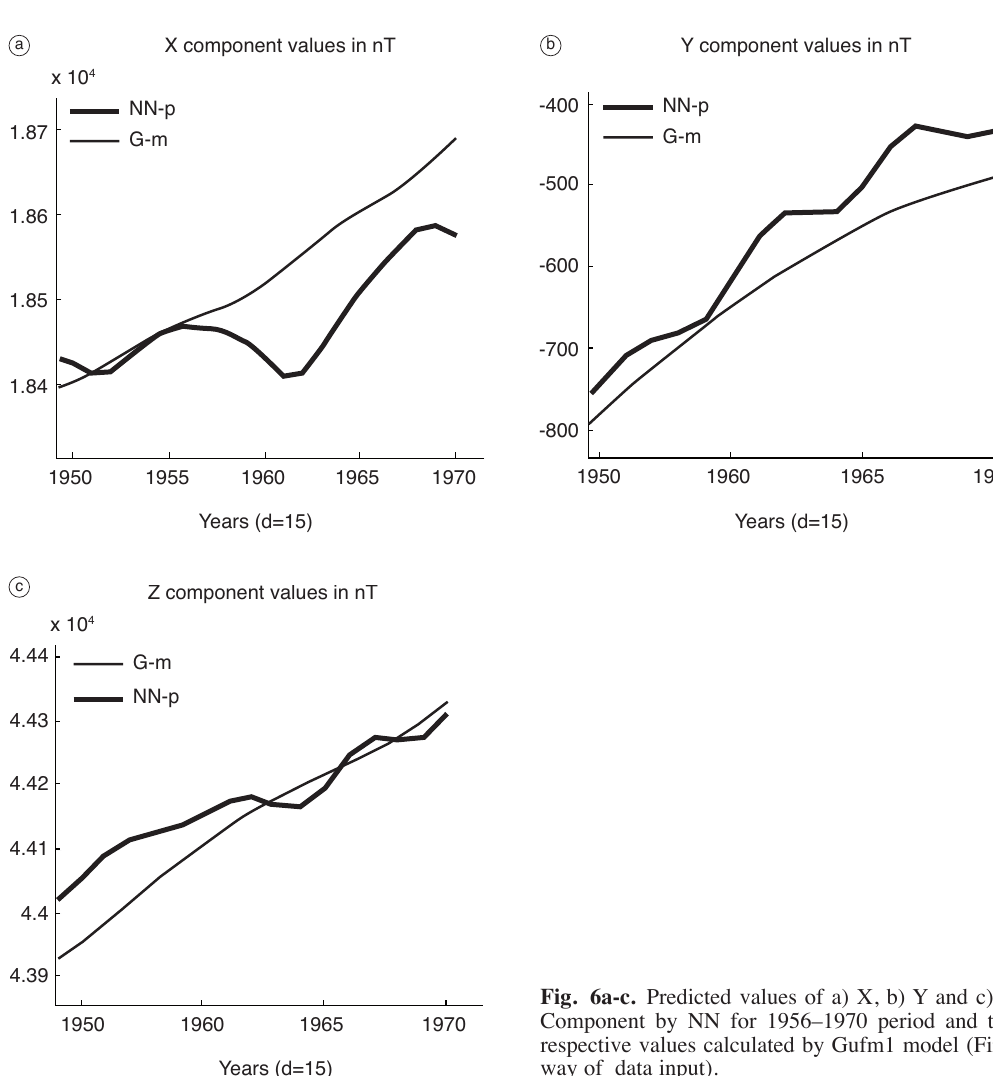
Table I. Rms and relative errors of prediction (first way of data input). Time prediction horizon in